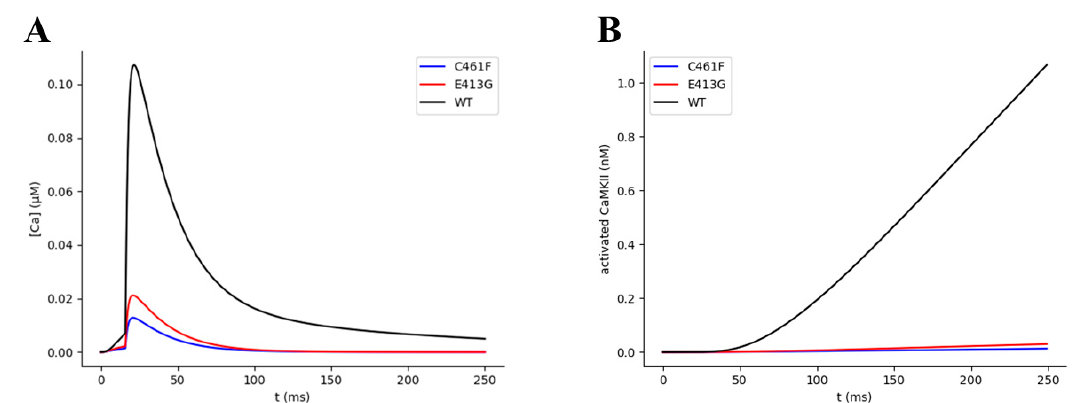
Figure 11. Variation of ( A ) Ca2+ concentration and ( B ) activated CaMKII over time for the WT and variant NMDA receptors. All simulations were performed under one pair of single pre- and post-synaptic pulses, with a pre-synaptic pulse of 1 ms of glutamate exposure, a delay between the pre- and the post-synaptic stimuli of 20 ms, and 1 mM of Mg 2+ .